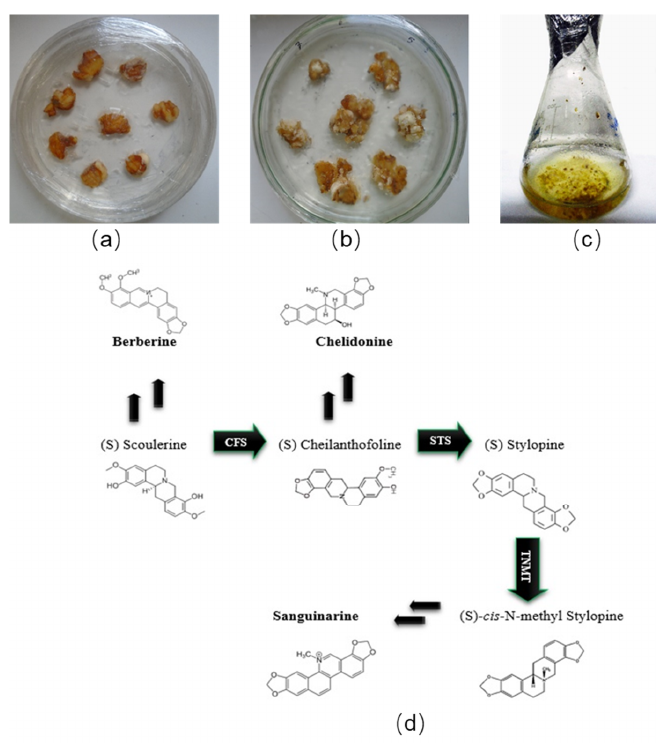
Figure 1. Callus and cell suspension culture of Greater Celandine. ( a ) The initiation phase of calli in leaf explants on Murashige and Skoog (MS) medium supplemented with 1 mg L − 1 of indole-3- acetic acid (IAA) and 0.2 mg L − 1 of 6-benzylaminopurine (BAP). ( b ) Callus culture on MS medium supplemented with 1 mg L − 1 IAA and 0.2 mg L − 1 BAP. ( c ) Cell suspension culture of Greater Celandine. ( d ) The metabolic pathway of benzophenanthridine alkaloids that illustrates the role ofCFS (cheilanthifoline synthase), STS (stylopine synthase), and TNMT (tetrahydroprotoberberine N -methyltransferase) enzymes